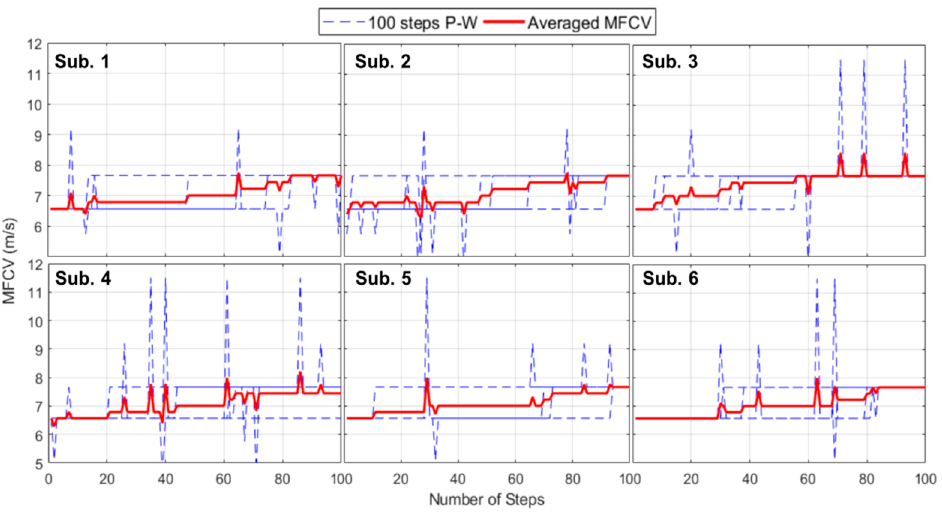
Figure 7. Subject-by-subject MFCV behavior in a power walk comprising five blocks of 100 steps (dashed blue line). In red, the average of the MFCV.